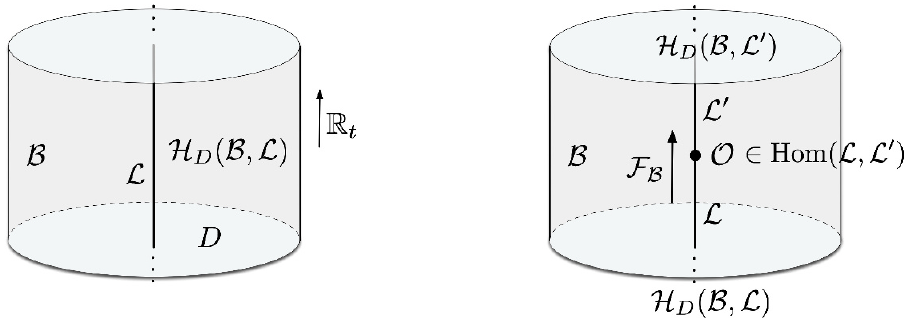
Figure 5 . Left: the SUSY Hilbert space condition . Right: using this setup to de(cid:12)ne a representation of the category of line operators on B the vector spaces ( ), for various ; H D B L